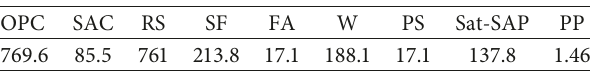
Table 2: Mixture proportions (kg/m 3 ) of cellular concrete.